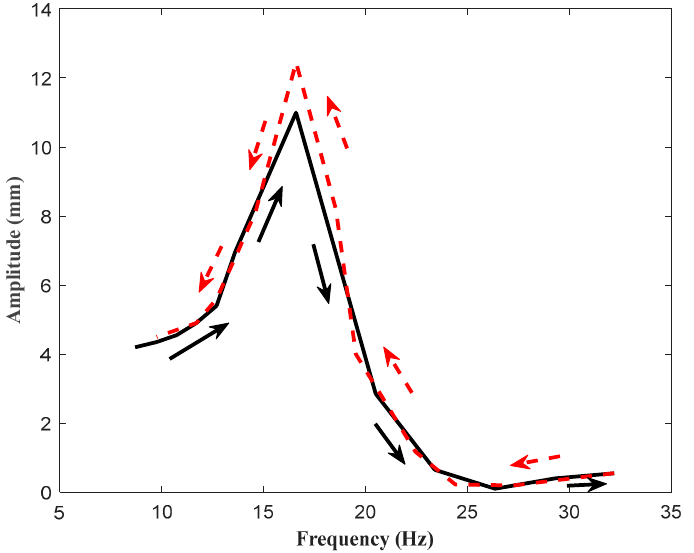
Figure 10. Vibration amplitudes of the bistable plates under low-level sinusoidal excitation at different frequencies.